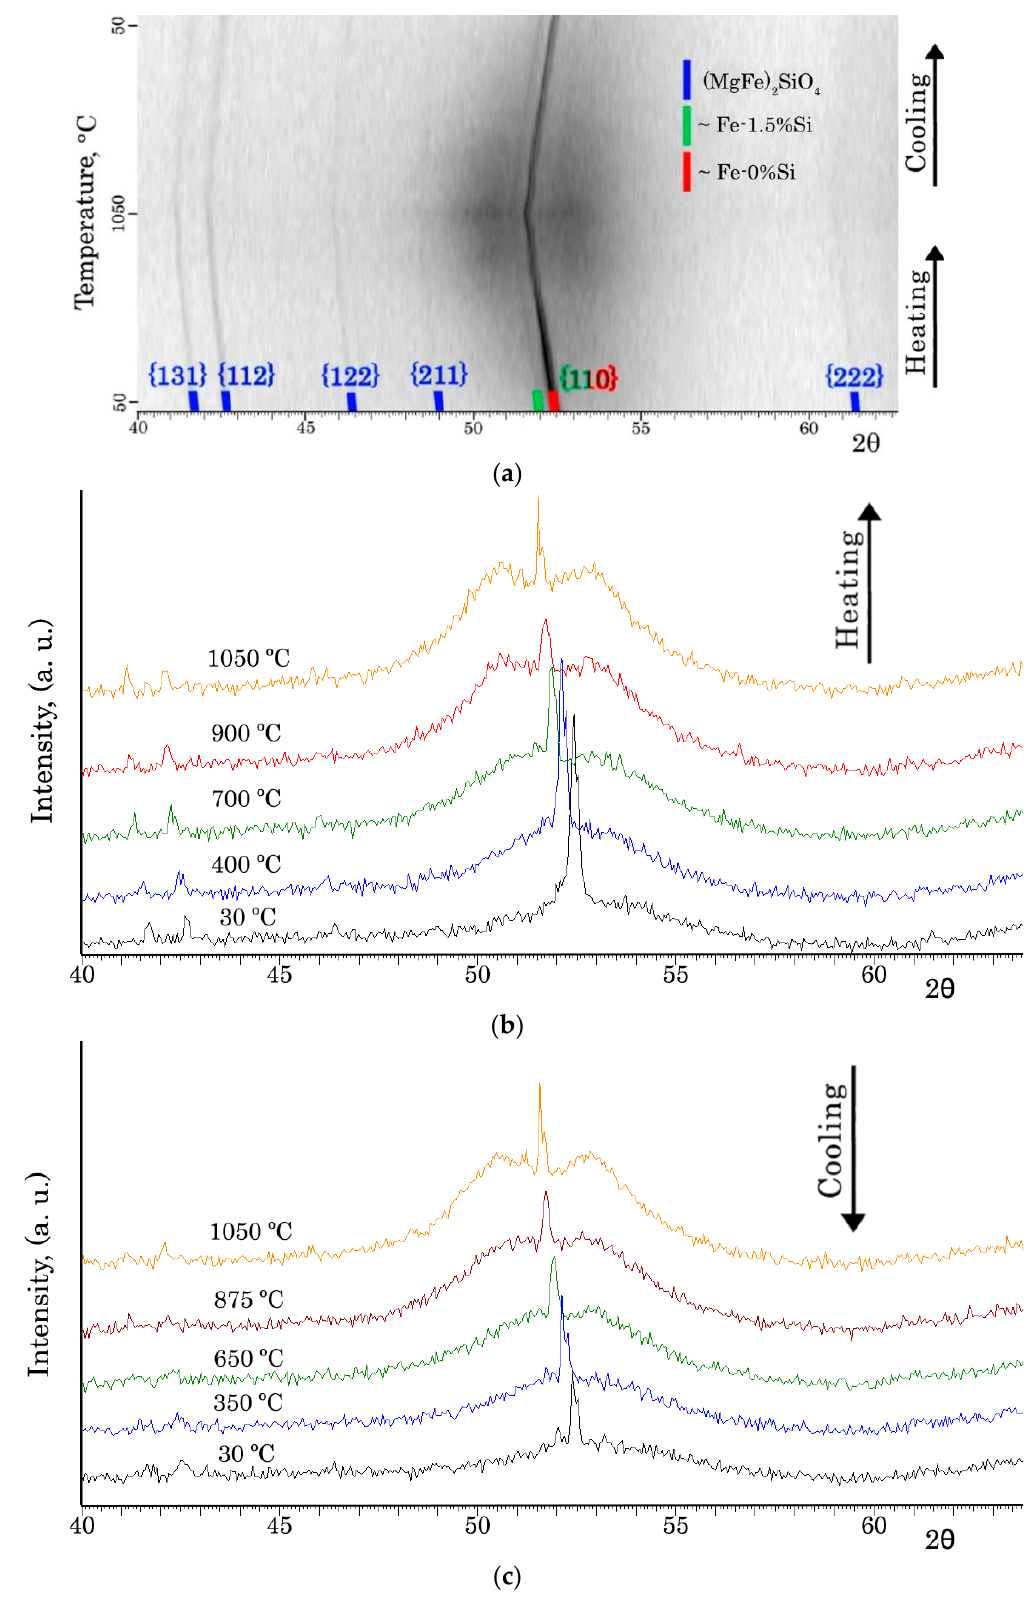
Figure 2. KαCo diffraction pattern of coated Fe -3%Si-0.5%Cu alloy after HTA: ( a ) during the entire Figure 2. K α Co diffraction pattern of coated Fe-3%Si-0.5%Cu alloy after HTA: ( a ) during the entire processing cycle; ( b , c ) during heating and cooling, respectively. processing cycle; ( b , c ) during heating and cooling,